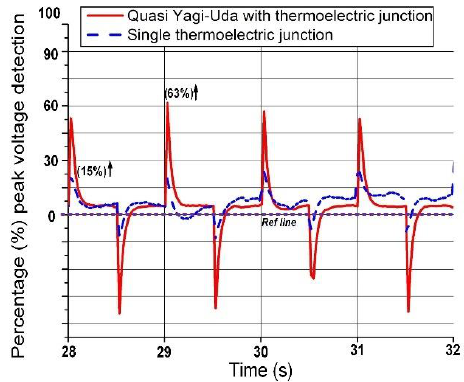
Figure 9. Influence of 650-nm laser pulses on quasi-Yagi–Uda nanoantenna and thermoelectric junction design in terms of voltage response.